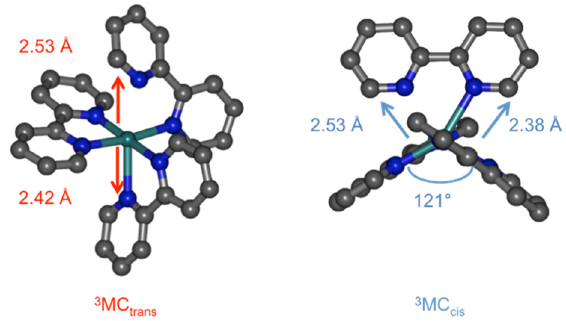
+ (H atoms not shown).